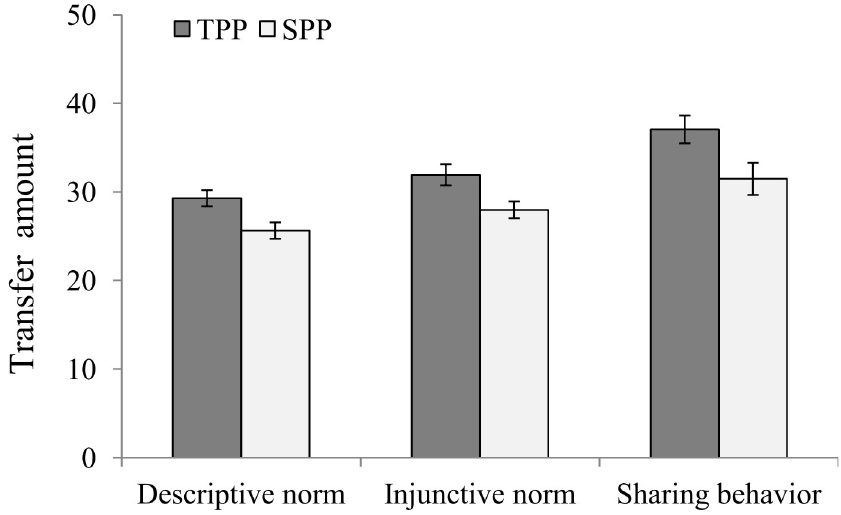
Fig 1. Descriptive and injunctive norm perceptions and sharing behaviors by group in Experiment 1 (error bars represent standard errors).